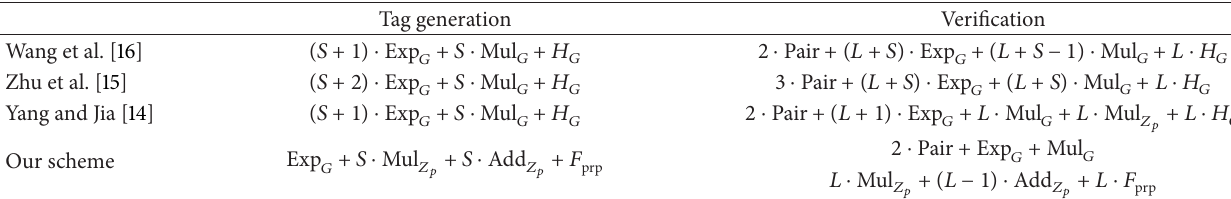
Table 2: Computation costs for a tag generation and